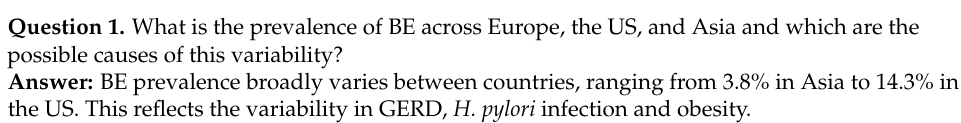
Table 1. Practice-oriented answers to clinical questions on the management of Barrett’s Esophagus. Question 1. What is the prevalence of BE across Europe, the US, and Asia and which are the possible causes of this